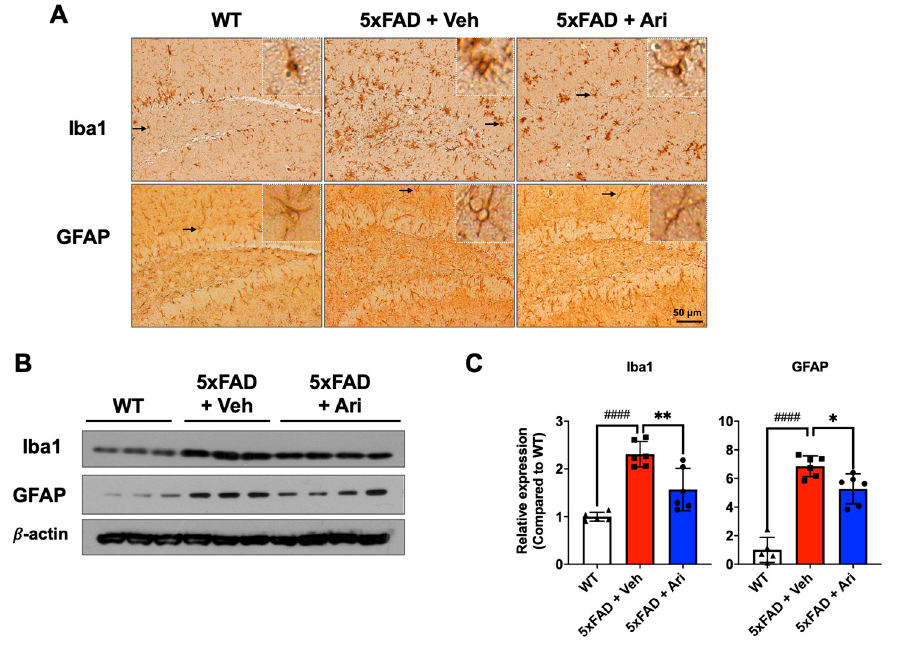
Figure 4. Aripiprazole treatment attenuated neuroinflammation in the hippocampus of 5xFAD mice. ( A ) Representative immunohistochemistry images of active microglia (Iba1-positive) and astrocytes (GFAP-positive) in 5xFAD mice treated with aripiprazole. Brown indicates Iba1 or GFAP positive staining. Inserted squares represent high magnification images of microglia or astrocytes as indicated with an arrow. Scale bar = 50 μ m. ( B ) Representative Western blots of Iba1 and GFAP in the hippocampus of WT, 5xFAD + Veh and 5xFAD + Ari mice. ( C ) Quantification of Iba1 and GFAP expression in hippocampal lysates for the indicated groups. Statistical significance using one-way ANOVA defined as #### p < 0.001, WT ( n = 5) vs. 5xFAD + Veh ( n = 6); * p < 0.05, ** p < 0.01, 5xFAD + Veh vs. 5xFAD + Ari ( n = 6) group. Error bars indicate SD.